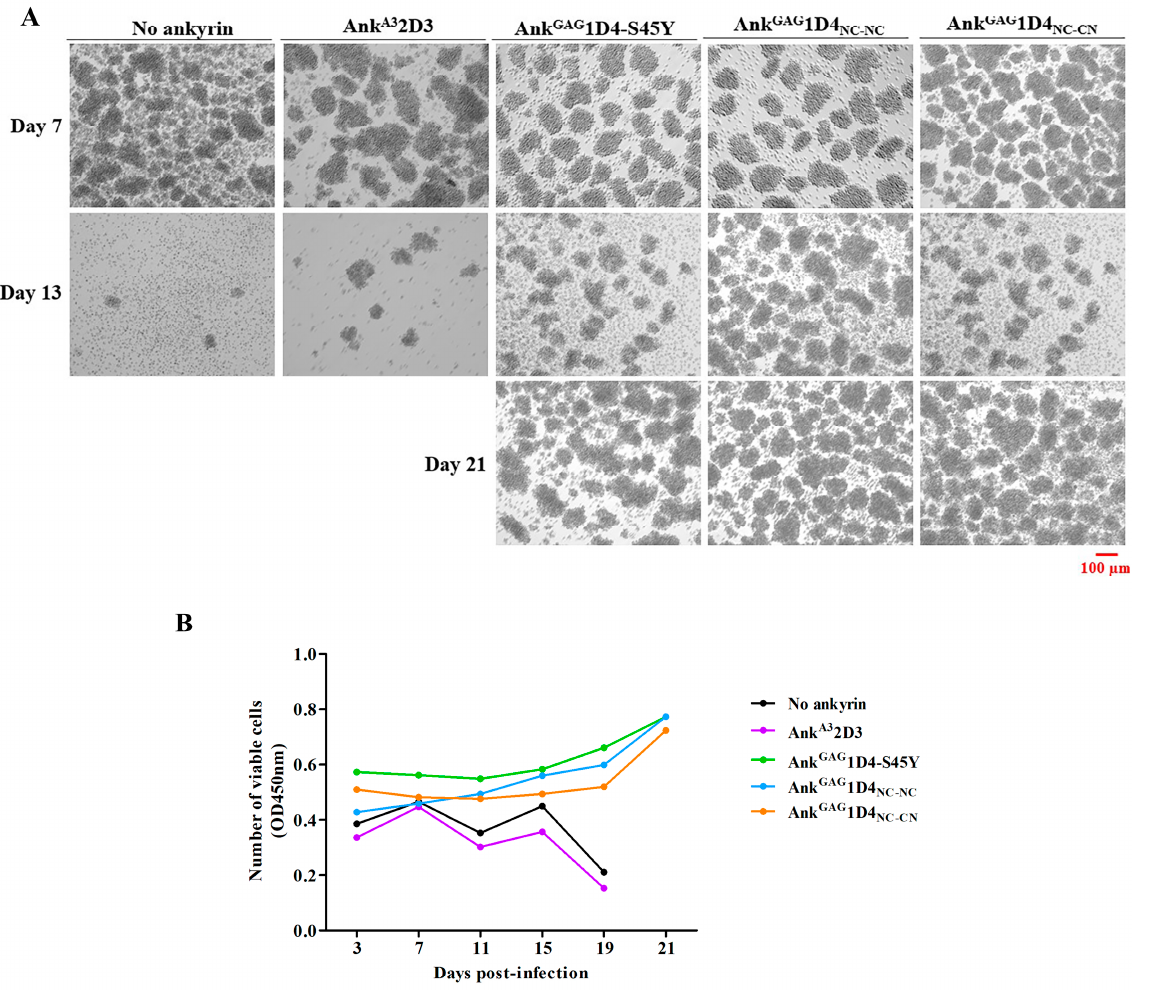
Figure 10. Cell morphology and cell viability of HIV-1 NL4-3 MIR CAI201V infected SupT1 cells. SupT1 and ankyrin-expressing SupT1 cells were infected with 10 MOI of HIV-1 NL4-3 MIR CAI201V virus. ( A ) Cell morphology was observed under inverted microscopy. Cell imaging was performed at 10 × magnification using Zeiss Axio vert A1. The image shown in this figure is representative of several image fields. Scale bar: 100 µ m ( B ) Cell viability of infected cells was determined by CCK-8 assay. The data represent the mean from triplicate wells. Ank A3 2D3, Ank GAG 1D4-S45Y, Ank GAG 1D4 NC-NC and Ank GAG 1D4 NC-CN represent SupT1 cells expressing Myr (+) Ank A3 2D3-EGFP, Myr (+) Ank GAG 1D4- S45Y-EGFP, Myr (+) Ank GAG 1D4 NC-NC -EGFP, and Myr (+) Ank GAG 1D4 NC-CN -EGFP,